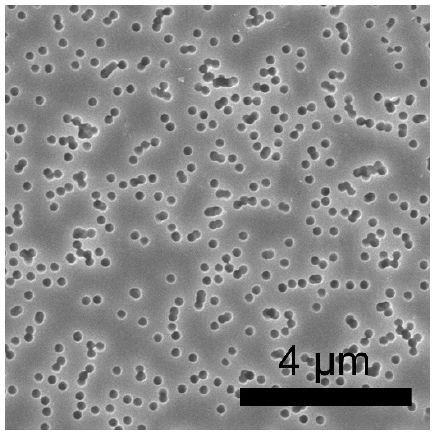
Figure 1. The SEM image of the polyimide track (nuclear) membrane. The pore density of the Belgian (it4ip, Belgium) commercial track polyimide mem- brane was 5 × 10 8 cm − 1 . With an average pore size of 200 nm, their degree of fi lling is ≈ 1.57% vol, with the polymer ≈ 98.43% vol.